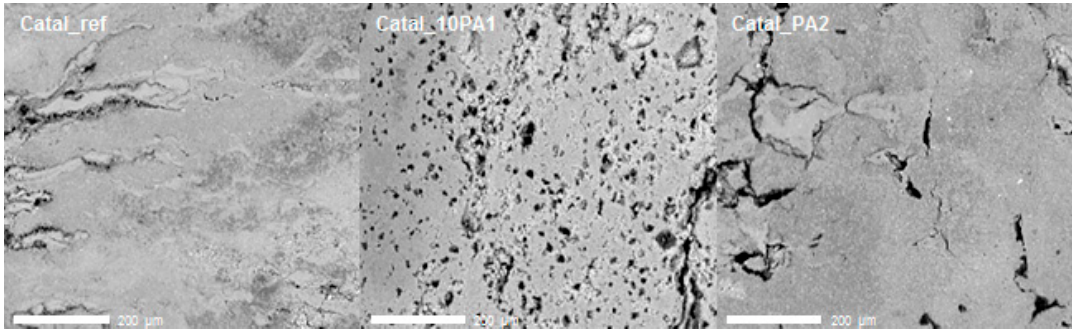
Figure 2. Microprobe SEM image of Catal_ref, Catal_10PA1, and Catal_PA2 revealing the macropores (black mark) formed by the presence of the pore former agent during the extrusion process.